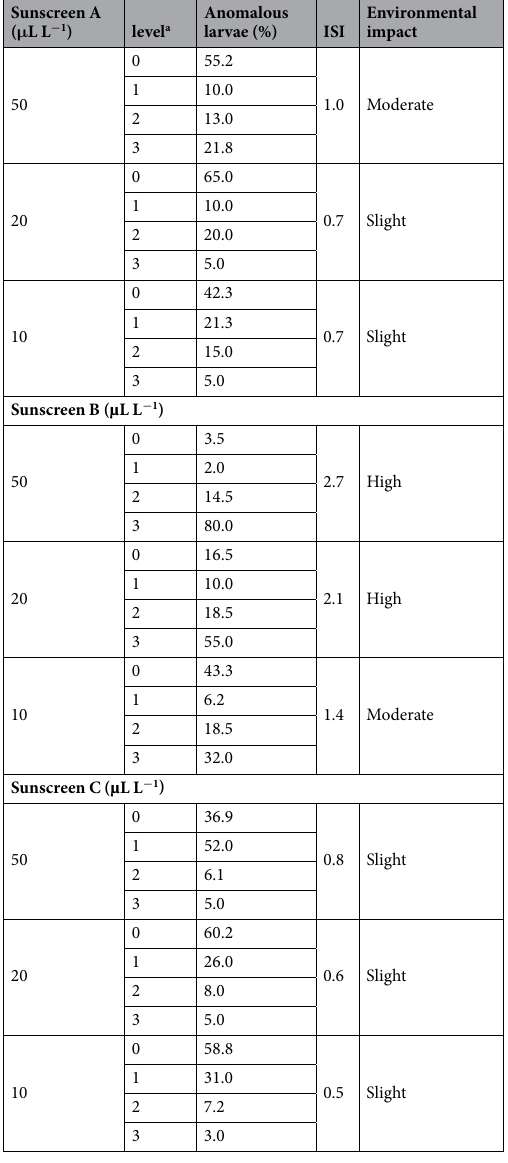
Table 1. Index of Sunscreen Impact (ISI) and environmental impact determined for each sunscreen at the different concentrations based on the level of larval alteration 35, 37, 38